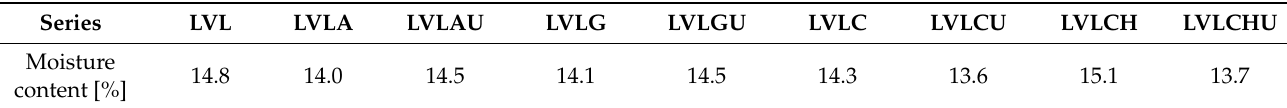
Table 4. Average moisture content value of laminated veneer lumber in each